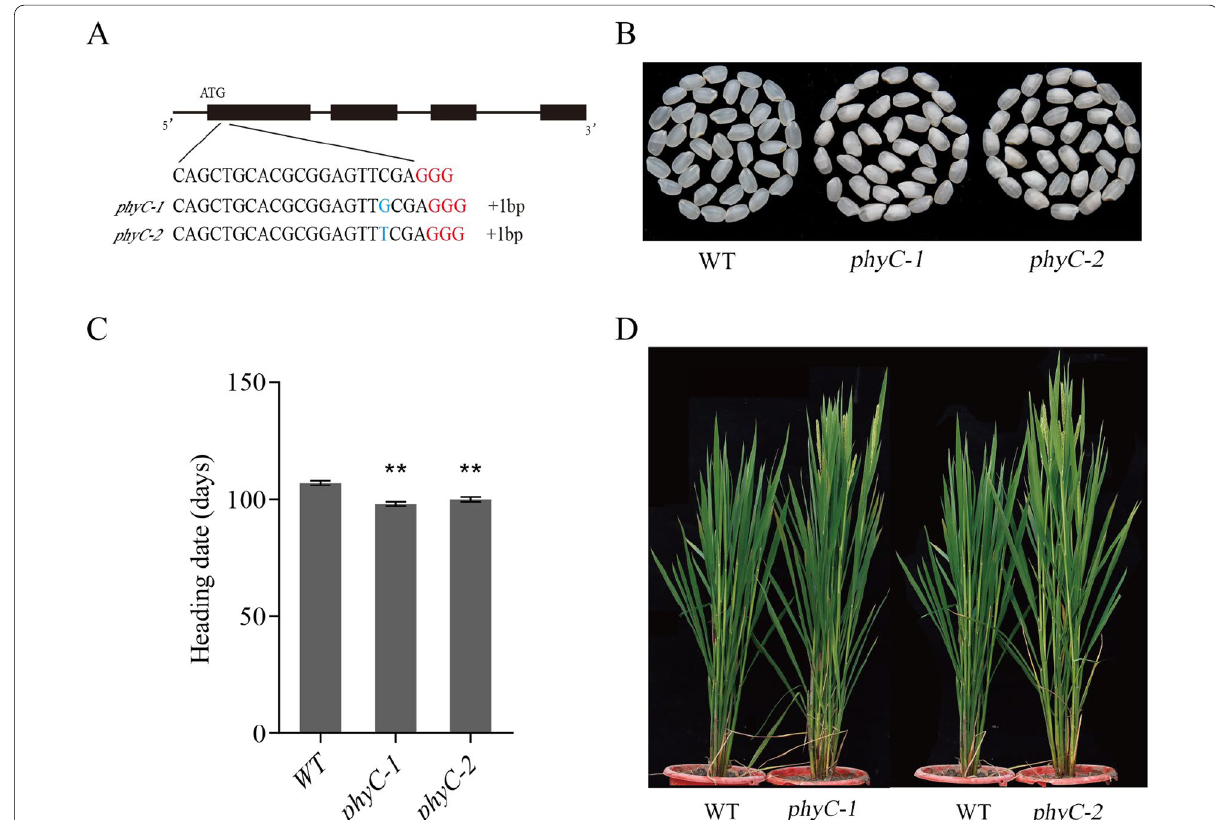
Fig. 1 Characterization of early‑maturing rice generated by CRISPR/Cas9‑mediated editing of PHYC . A Schematic diagram of the PHYC gene and the position of the editing target site. Black boxes and lines in between represent exons and introns, respectively. The target sequence is shown in black and the PAM sequence (CGG) in red. Underneath the target sequence is the sequence alignment to show the 1‑bp insertion (highlighted in blue) induced by gene editing in the two independent transgenic lines ( phyC-1 and phyC-2 ). B Comparison of the morphology of the milled rice grains from T 2 plants. C Comparison of heading date between the two mutants and the wild‑type. D Plant morphology of the PHYC mutants ( phyC-1 and phyC-2 ;